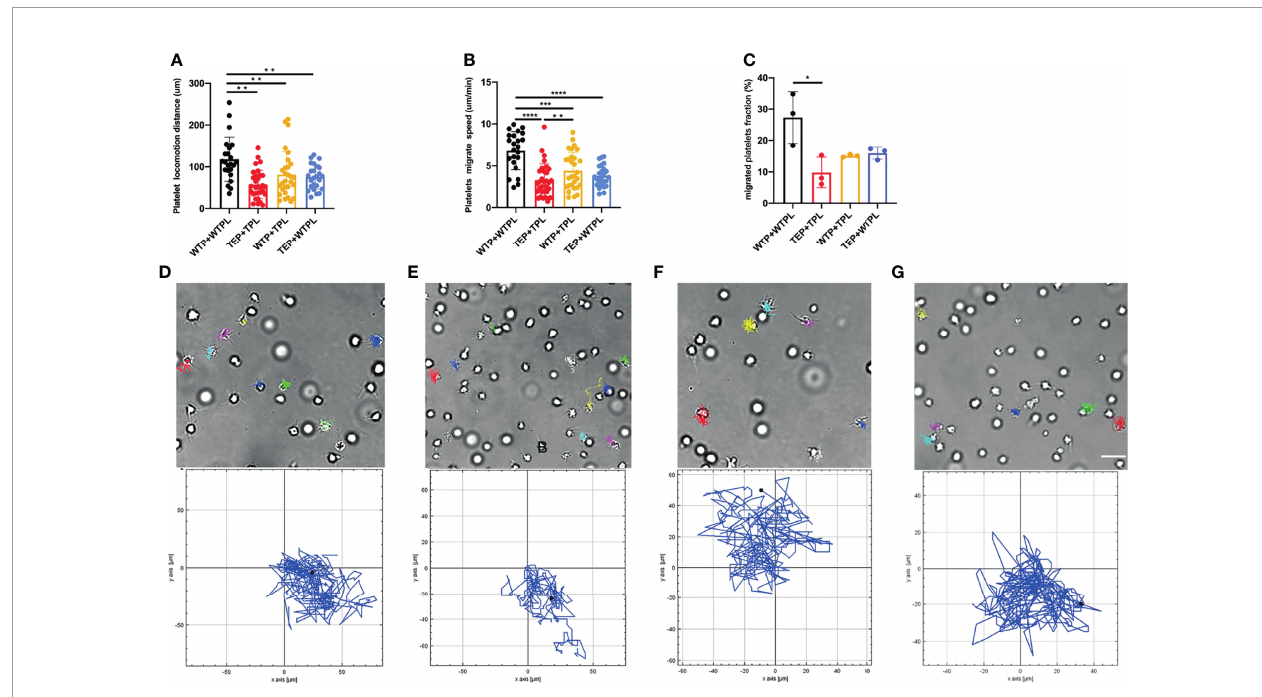
FIGURE 2 | Platelet migration in plasma. (A) WTP+WTPL migrated the longest distance among all the four groups. (B) WTP+WTPL migrated fastest in the four groups; WTP+TPL could migrate faster than TEP+TPL. (C) There were more migrated platelets in WTP+WTPL than in TEP+TPL, migrated platelet fraction = migrated platelets/the platelets in the whole focus. (D – G) Platelets migrated track of WTP+WTPL (D) , TEP+TPL (E) , WTP+TPL (F) , and TEP+WTPL (G) , respectively. The cell tracks relative to each group are under each cell-migration picture. Different colors are used to mark different platelet tracks. The scale bar represents 7 m m; n = 3 experiments; mean ± SEM; Students-t and ANOVA test; *p < 0.05; **p < 0.01; ***p < 0.001; ****p < 0.0001; plt, platelet; WTP, wild-type platelet; TEP, tumor- educated platelet; WTPL, wild-type mice plasma; TPL, tumor mouse